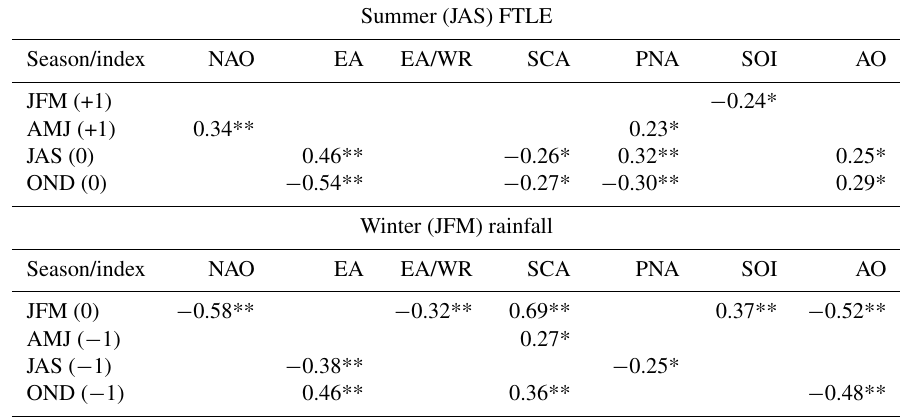
Table 2. Seasonal correlations between summer (JAS) FTLE anomalies, winter (JFM) rainfall and different teleconnection indices; the North Atlantic Oscillation (NAO), the East Atlantic pattern (EA), the East Atlantic/western Russia (EA/WR), the Scandinavian pattern (SCA), the Pacific/North American teleconnection pattern (PNA), the Southern Oscillation Index (SOI), and the Arctic Oscillation (AO). Only significant values are shown. (*) and (**) stand for significances larger than 95 and 90%, respectively. ( + 1 , 0 , − 1 ) correspond to the preceding, same and following seasons,